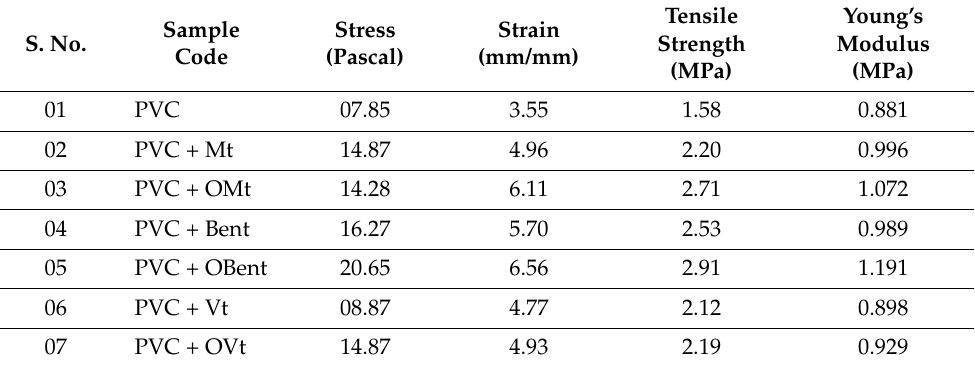
Table 3. Tensile strength and Young’s modulus of pristine and organo-clay-based PVC polymer composite